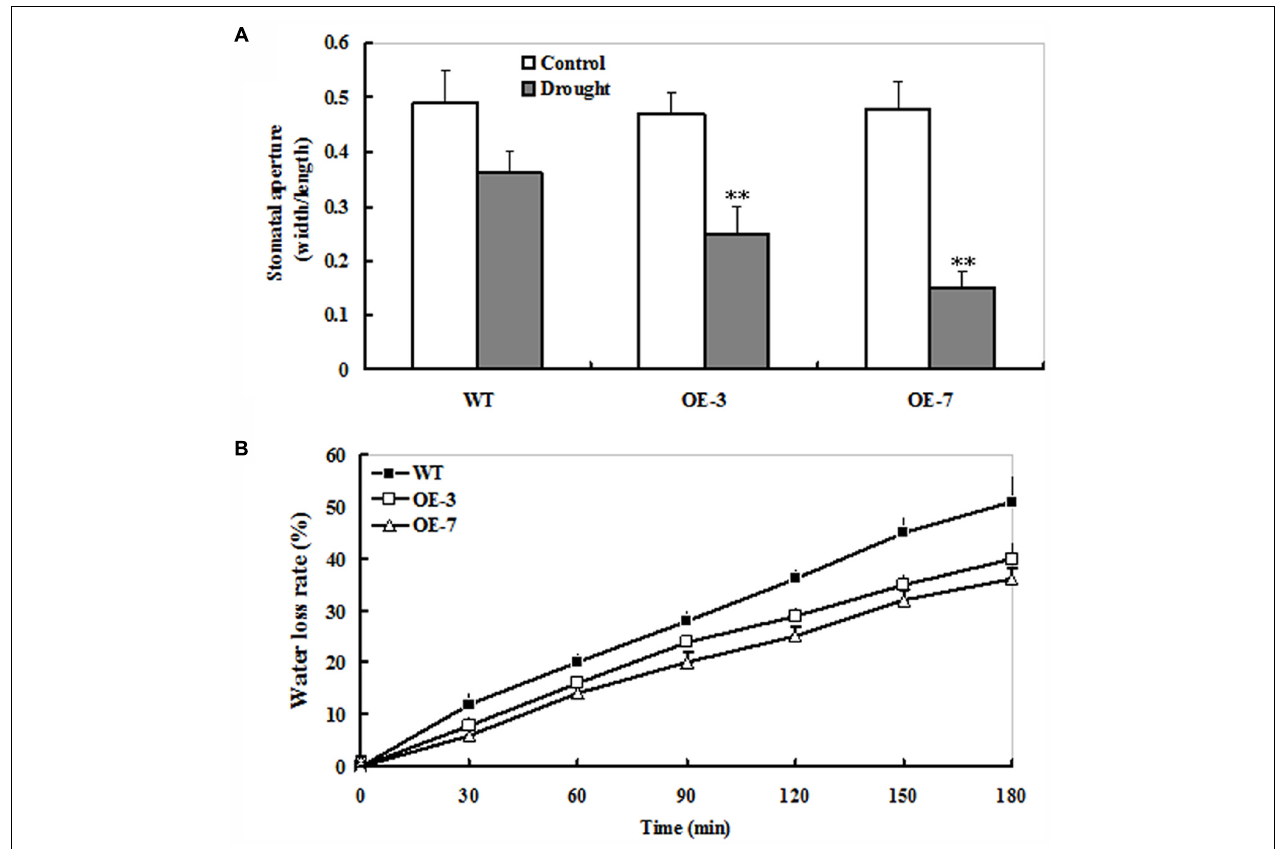
FIGURE 3 | Changes of water loss rate and stomatal apertures in the WT and ZmSO -overexpressing tobacco lines under water stress. (A) Stomatal apertures. The mean ratio of width to length of at least 20 stomatal apertures was measured in epidermal peels from leaves of WT and both OE (OE-3 and OE-7) plants upon 9 days of drought stress. Bar indicates SE. ∗∗ t -test, with P < 0.01. (B) Water loss rate. Water loss was monitored by measurement of fresh weight loss from detached leaves of WT and both OE (OE-3 and OE-7) plants at same development age under stressed and control conditions at time intervals indicated. Bars indicate SE, n =